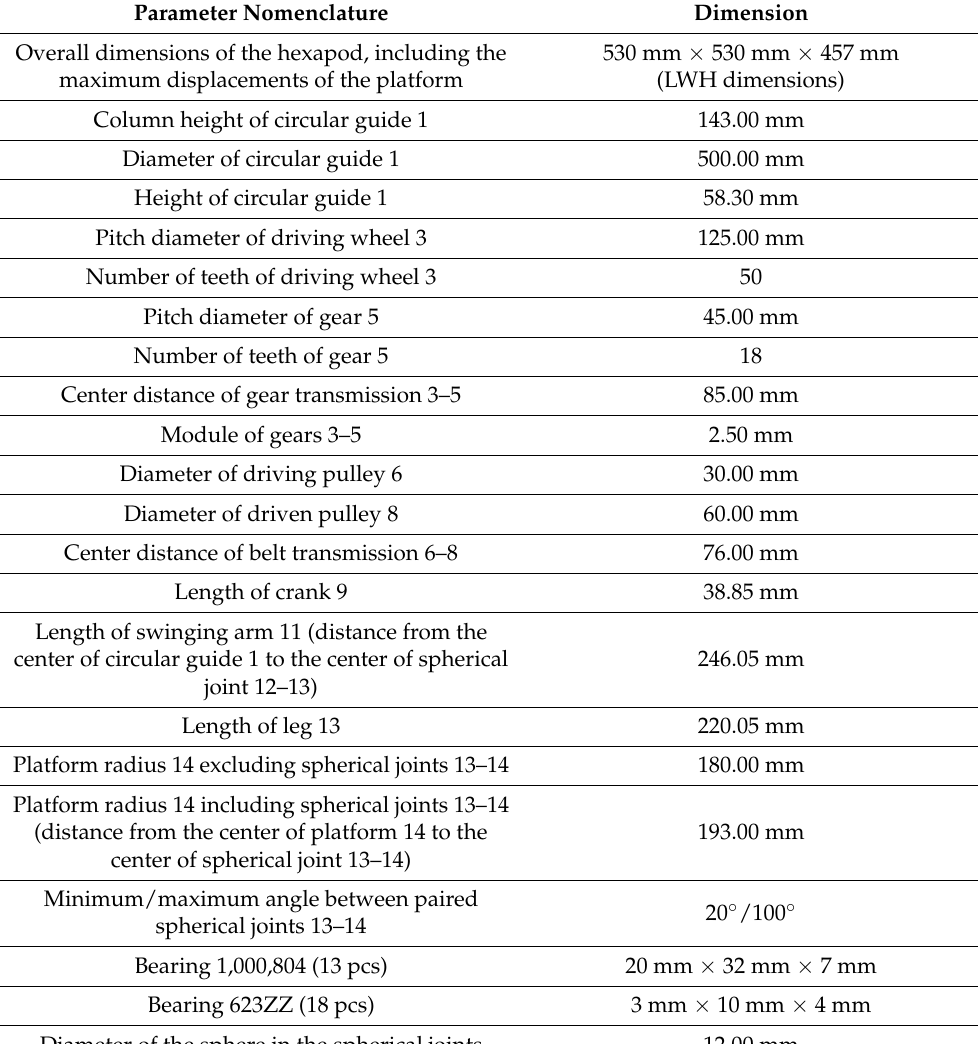
Table 2. Geometrical dimensions of the hexapod